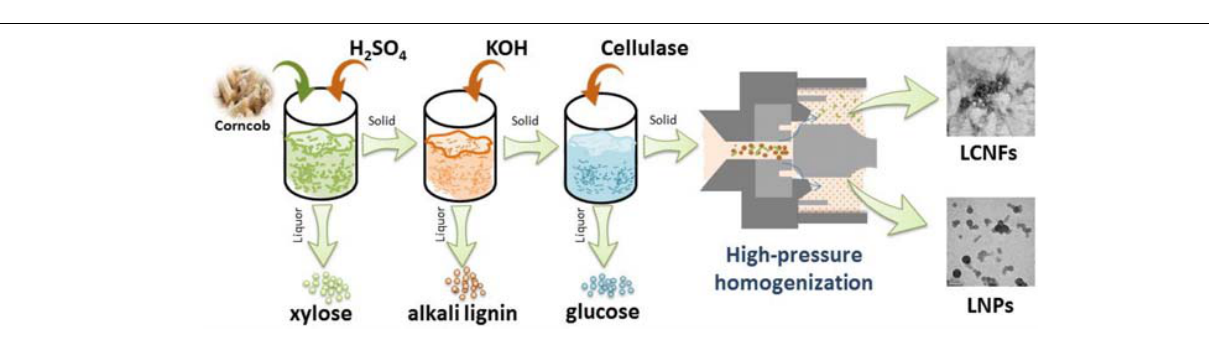
FIGURE 7 | Proposed process for the full utilization of